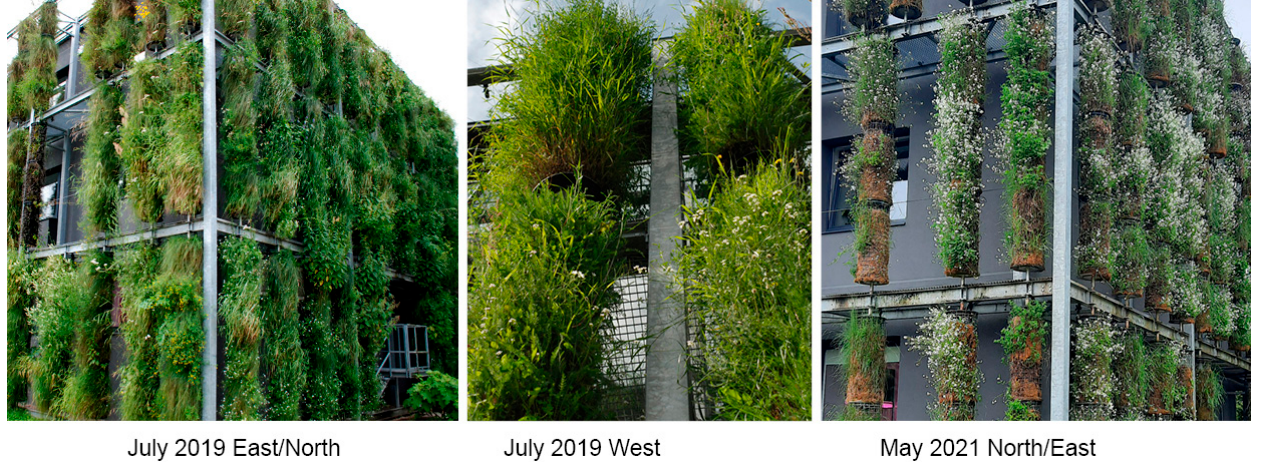
Figure 5. The green columns during the third year’s summer season on the east/north and west expositions, July 2019; A. arenosa ’s dominant representation in the fifth year’s spring season on the east/north exposition, May 2021.